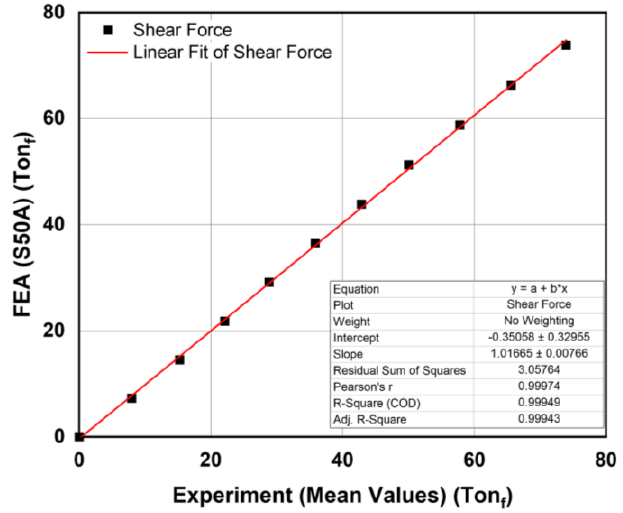
Figure 14. Correlation of the shear force between the experiment and the FEA when shore hardness of the elastomer is 50A.